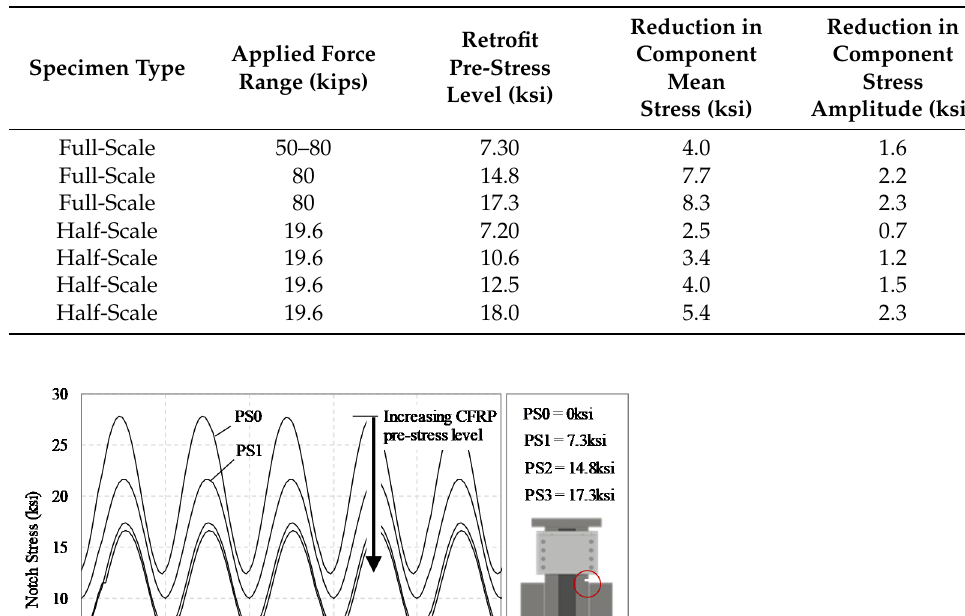
Table 9. Mean and amplitude stress shift due to the CFRP pre-stress level.